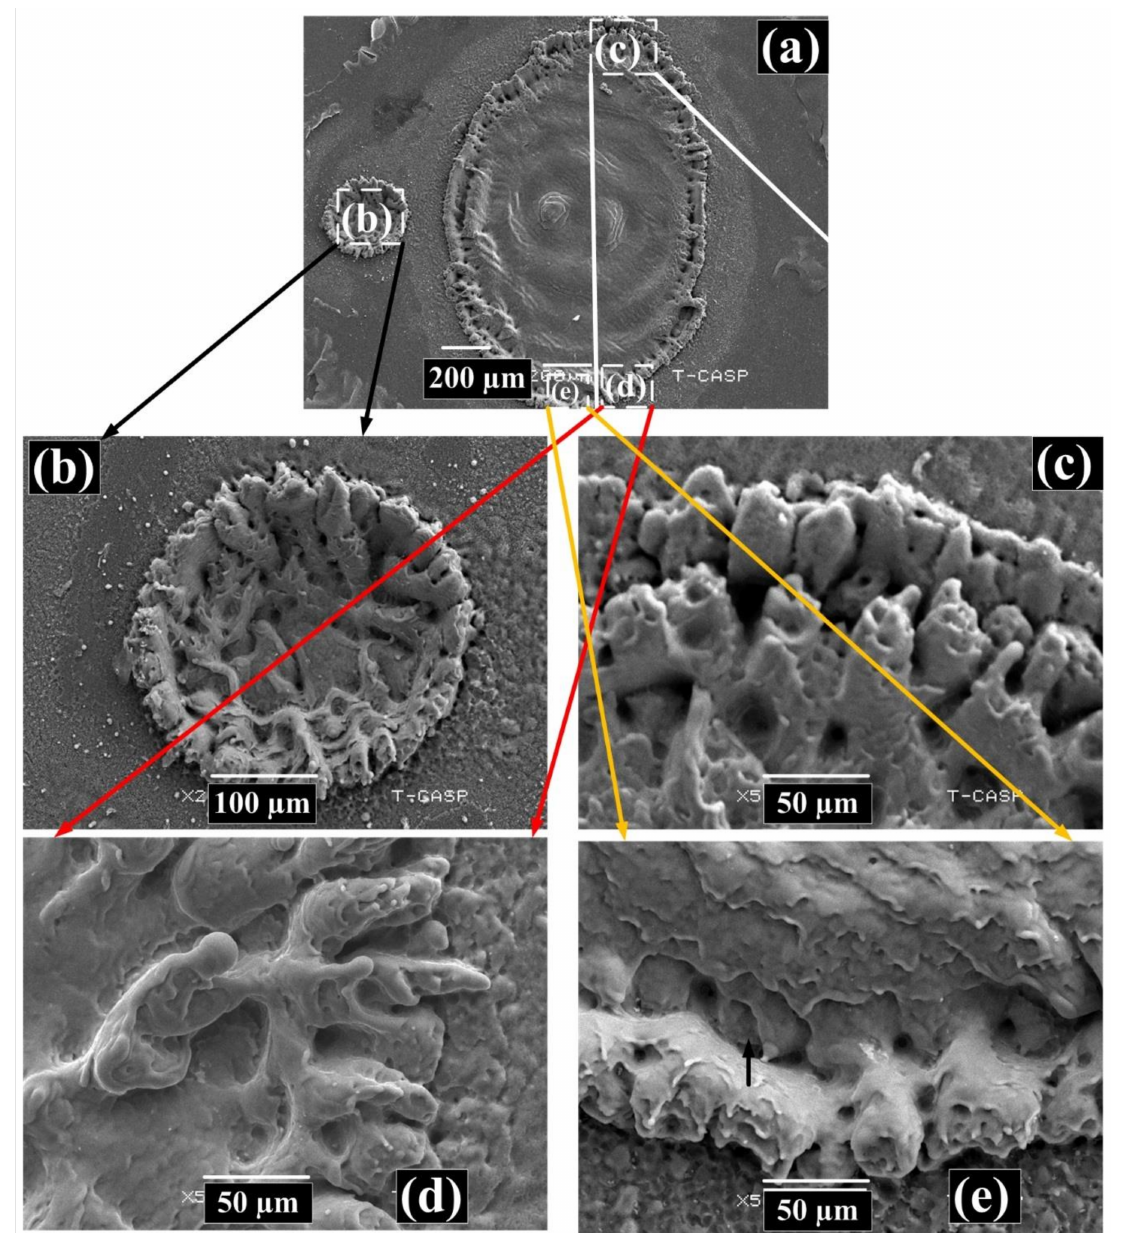
Figure 14. SEM images of the laser-irradiated areas of Mg showing the different surface features under He ambient environment at a constant pressure of 5 Torr and laser irradiance of 2.0 GW/cm 2 in the magnetic field-free case, where ( a ) laser-ablated crater of the Mg, ( b ) small crater near the main laser-ablated area, ( c ) non-uniform cones with cavities on the cones, ( d ) forward-peaked cones with wide bases and spherical caps on top, and ( e ) cavities and cones due to turbulent melt flow of molten material towards the outer